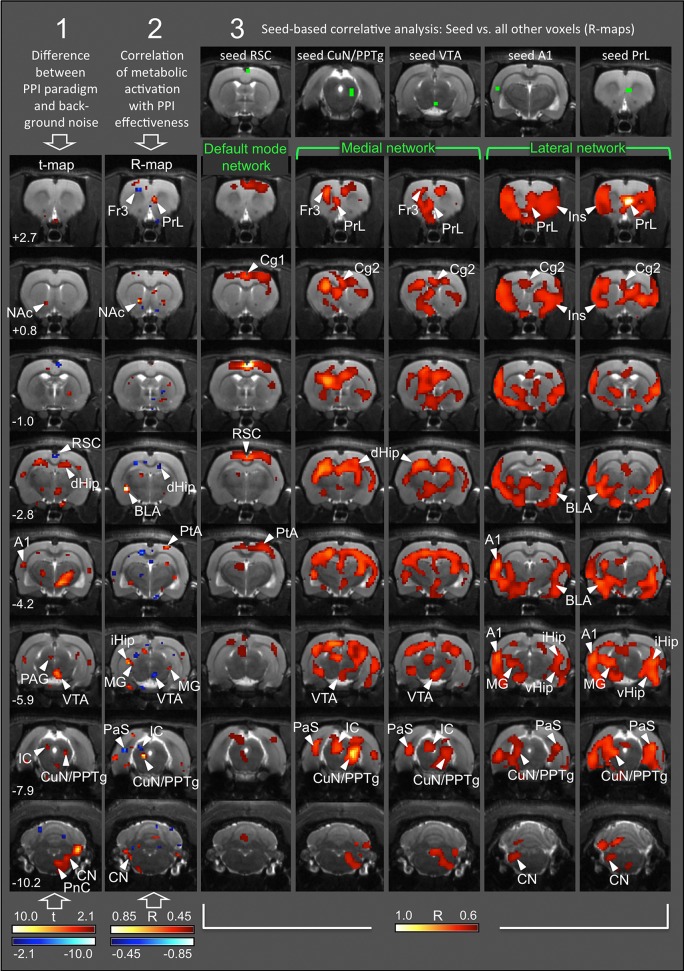
Functional connectivity networks arising during PPI. Each column represents a single analysis, with statistical maps projected onto transverse MR images from one of the rats used in this study. Numbers (rows) correspond to rostrocaudal coordinates in mm from Bregma. Column 1: t-map from comparison of FDG uptake between PPI and background sessions, based on n = 19 pairs of individual cumulative images. Red, FDG uptake higher during PPI; blue, FDG uptake higher during background control. Only significant differences (p < 0.05, uncorrected) are shown. Column 2: R-map from correlation analysis between intra-individual difference images (background minus PPI; n = 19) and PPI effectiveness. Red, the more PPI events, the higher the metabolic activity. Blue, the more startle events, the higher the metabolic activity (−0.45 < R >0.45; p < 0.05, uncorrected). Columns 3–7: R-maps from correlation analyses between seed area (green voxels; top row) and all other brain voxels, based on n = 19 intra-individual difference images. There were significant positive correlations only (R > 0.60; p < 0.01, TFCE-corrected). A1, primary auditory cortex; BLA, basolateral amygdala; Cg1/2, anterior cingulate nucleus 1/2; CN, cochlear nucleus; CuN, cuneiform nucleus; dHip, dorsal hippocampus; Fr3, frontal cortical area 3; IC, inferior colliculus; iHip, intermediate hippocampus; Ins, insular cortex; MG, medial geniculate nucleus; NAc, nucleus accumbens; PAG, periaqueductal gray; PaS, parasubiculum; PnC, caudal pontine reticular nucleus; PPTg, pedunculopontine tegmental nucleus; PrL, prelimbic cortex; PtA, parietal association cortex; RSC, retrosplenial dysgranular cortex; RtTg, reticulotegmental nucleus of the pons; SC, superior colliculus; SON, superior olivary nucleus; TeA, temporal association cortex; vHip, ventral hippocampus; VP, ventral pallidum; VTA, ventral tegmental area.